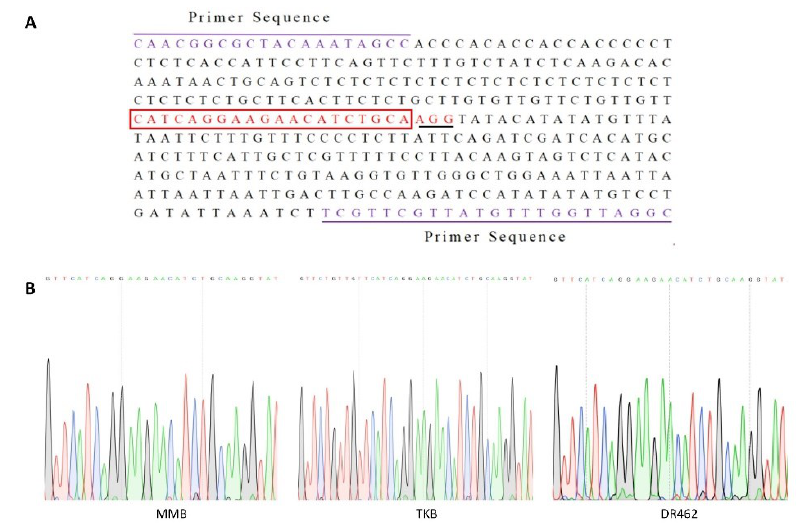
Figure 1. Location of sgRNA in the Wx gene and designed primers for amplification. ( A ): Wx gene partial sequence showing target positions and primer sequences; purple nucleotides: Upstream and downstream primers; Red Box: sgRNA sequences; black underline nucleotides: protospacer adja- cent motif (PAM) region; ( B ): Sequencing peak map of sgRNA.